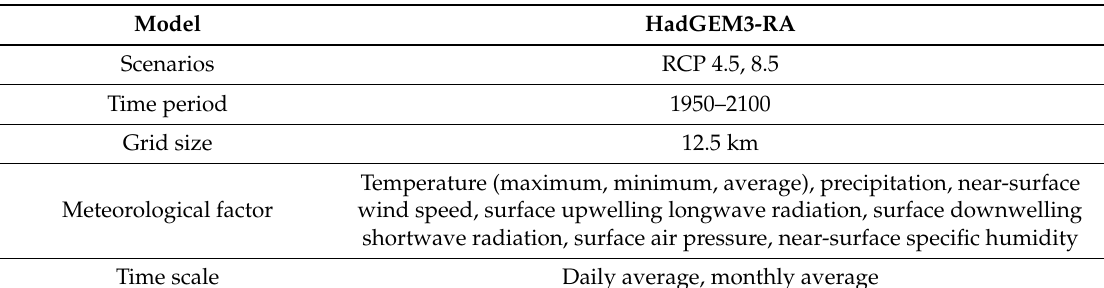
Table 1. NIMR climate change scenario data.